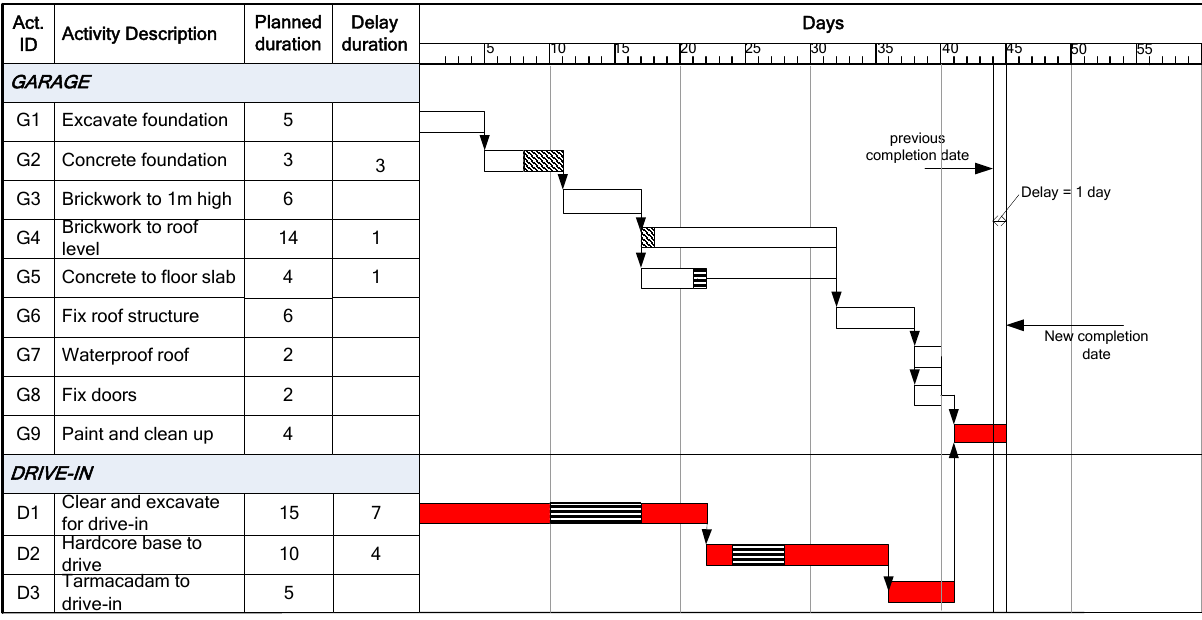
Figure 9. Impact of fifth delay.